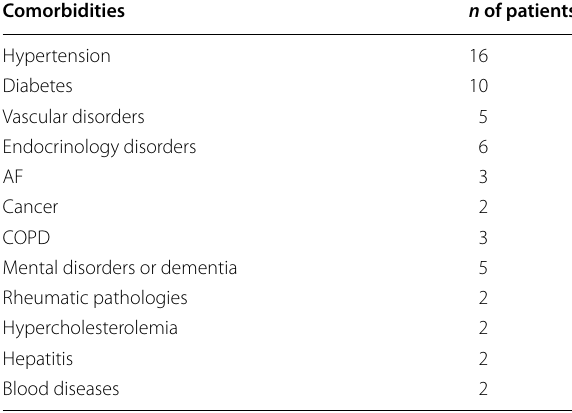
AF Atrial fibrillation; COPD chronic obstructive pulmonary disease